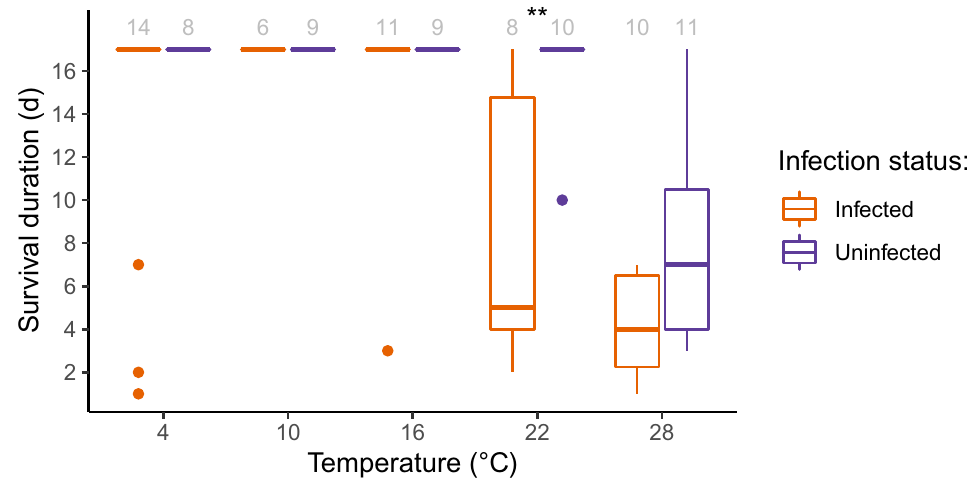
Figure 2. Survival duration of Littorina littorea uninfected and infected by Himasthla elongata after a 17-day post-acclimation exposure to different temperatures. Asterisks represent significant differences between infected and uninfected individuals (Mann–Whitney-U-Test, Holm-corrected p < 0.01). Gray numbers represent sample